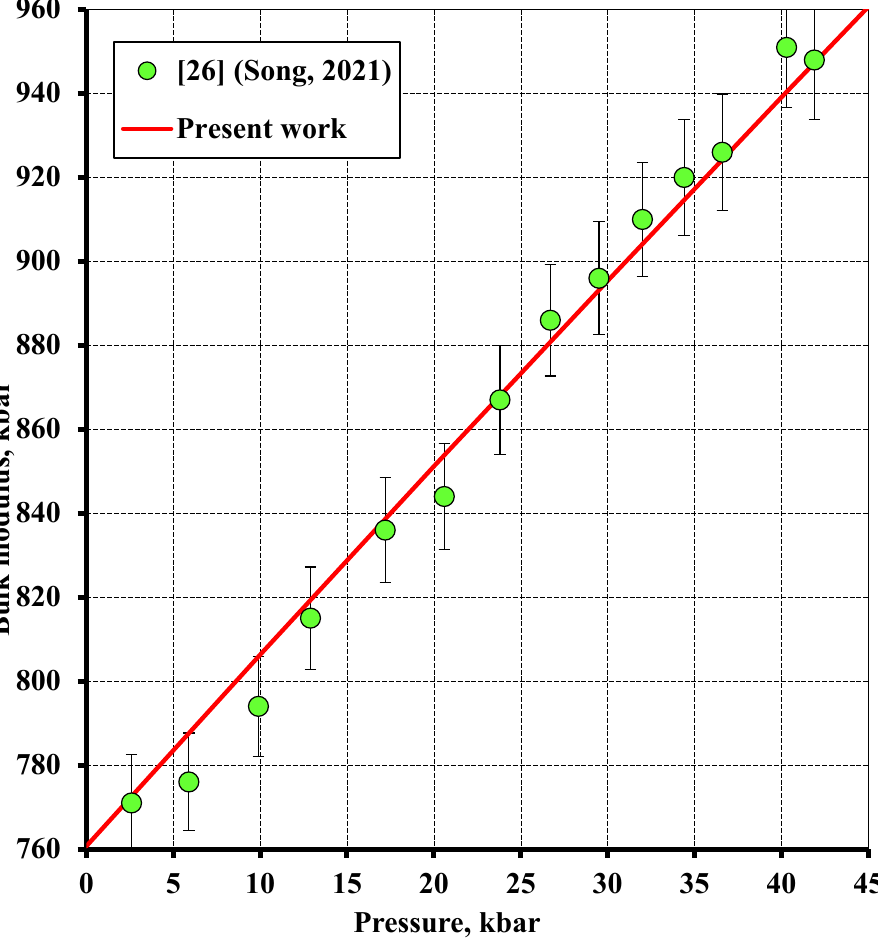
Figure 3 illustrates the molar volume of aluminum plotted against pressures up to 1000 kbar. The experimental points totaled 113. The mean absolute deviation be- tween the calculation and experiment over the entire pressure range was 0.018 cm 3 /mol, RMS = 0.30%. Table 5 compares the Tait equation of state parameters obtained herein with those from the literature. The calculated isothermal bulk modulus at 298.15 K was 728.6 kbar and is on par with the literature data listed in Table 5.